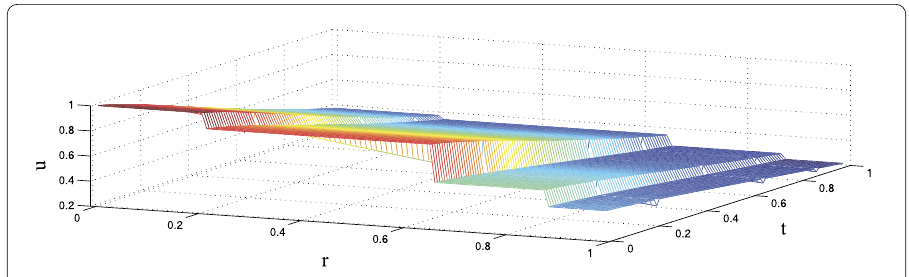
Figure 1 The solution graph for local fractional diffusion equation when μ =